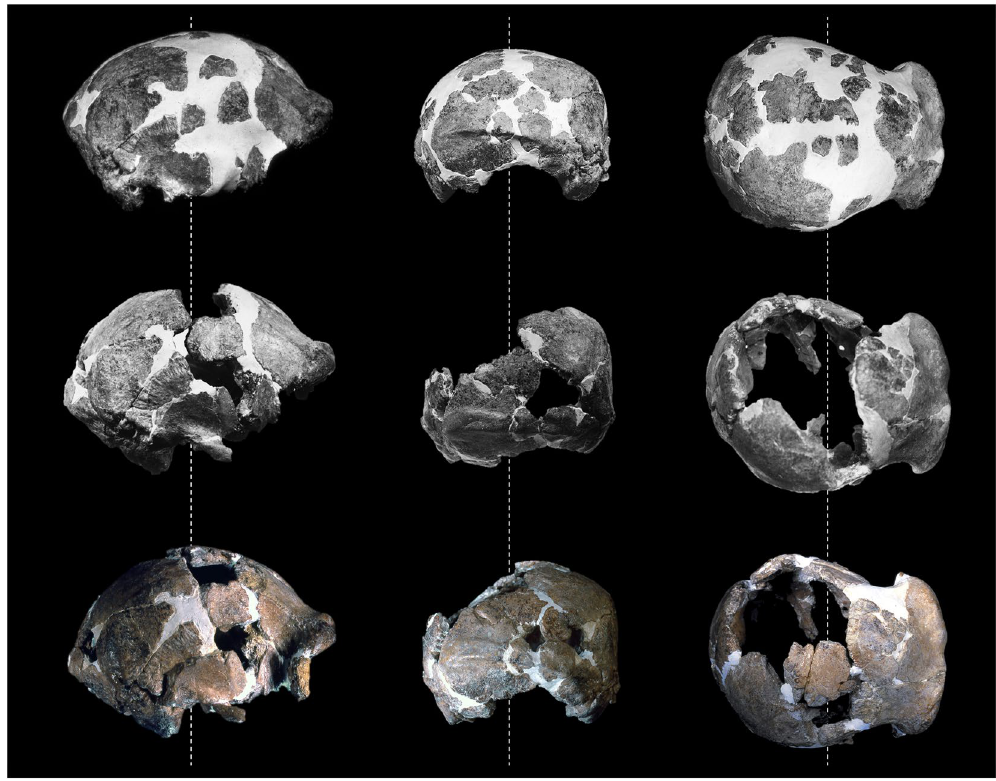
Figure 1. Three stages of the challenging process of restoration of the Ceprano calvarium performed directly on the original specimen by various workers between 1994 and 1999. As described in the text, the reconstruction was originally performed under the direction of the late A. Ascenzi (top row), subsequently corrected by R.J. Clarke (middle), and revised by M.A. de Lumley, F. Mallegni and co-workers